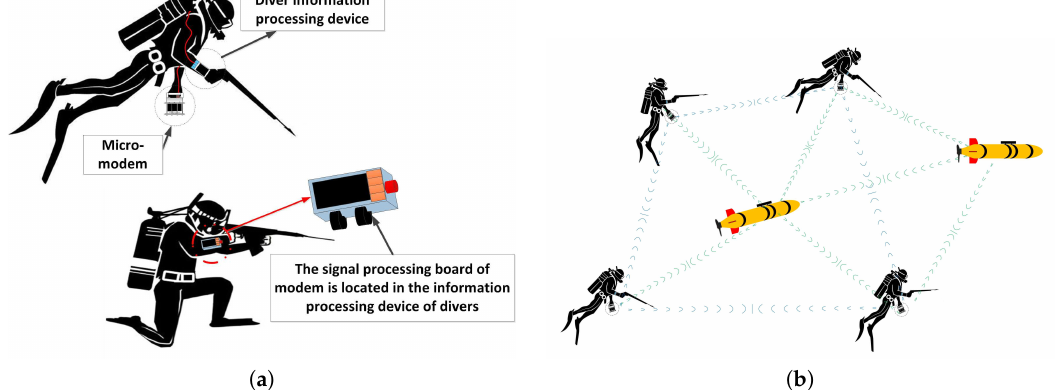
Figure 1. ( a ) Frogmen equipped with modems; ( b ) Communication among divers and UUVs over